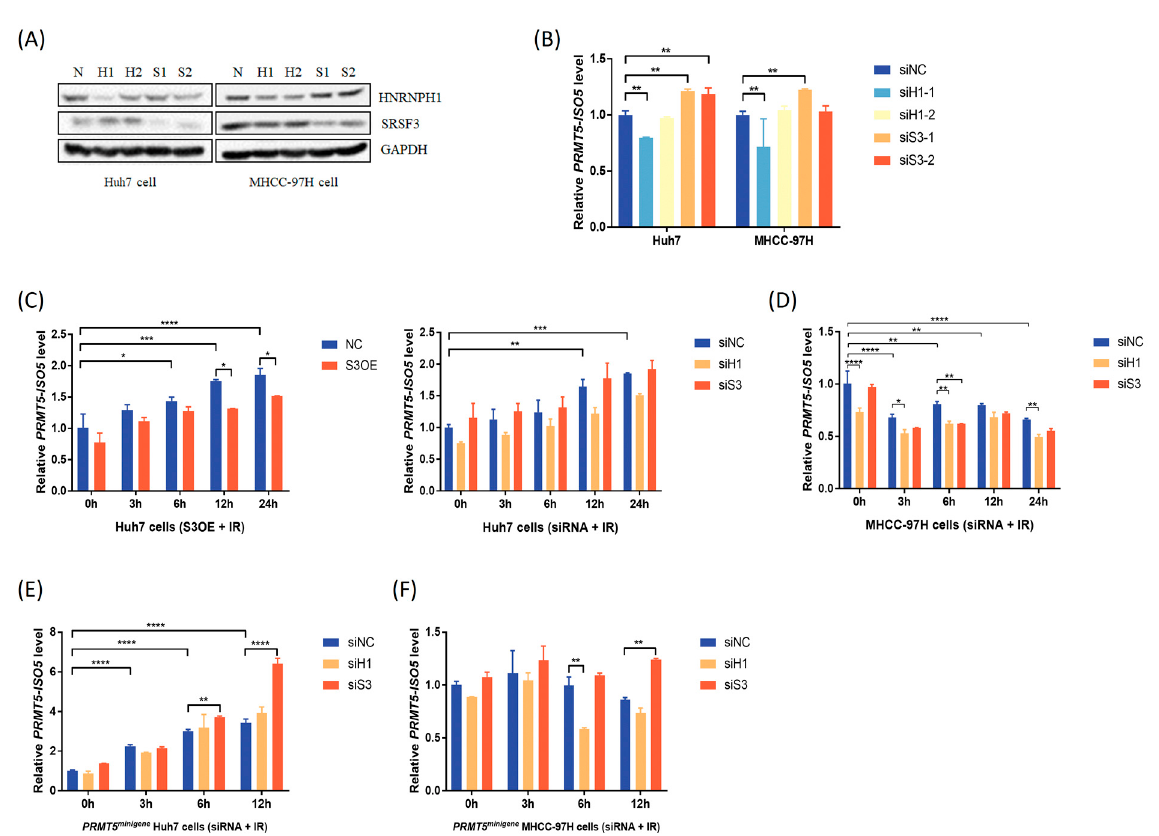
Figure 3. SRSF3 and HNRNPH1 play opposite roles in PRMT5-ISO5 production induced by IR. ( A ) The efficiencies of HNRNPH1 silencing or SRSF3 depletion. H1/2: si- HNRNPH1 -1/2, S1/2: si- SRSF3 -1/2; N: nonsense siRNA. ( B ) The transcriptional level of PRMT5-ISO5 induced by HN- RNPH1 silencing or SRSF3 depletion (siH1-1/2: si- HNRNPH1 -1/2, siS3-1/2: si- SRSF3 -1/2;